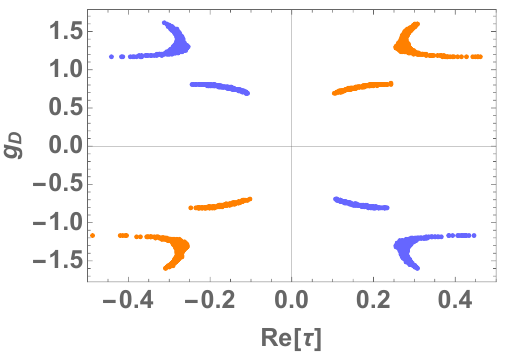
Figure 7 . The sign of Y B and regions of Re[ τ ] – g D . Orange and blue points denote positive and negative Y B , respectively. Points corre- spond to the output of section 4 at